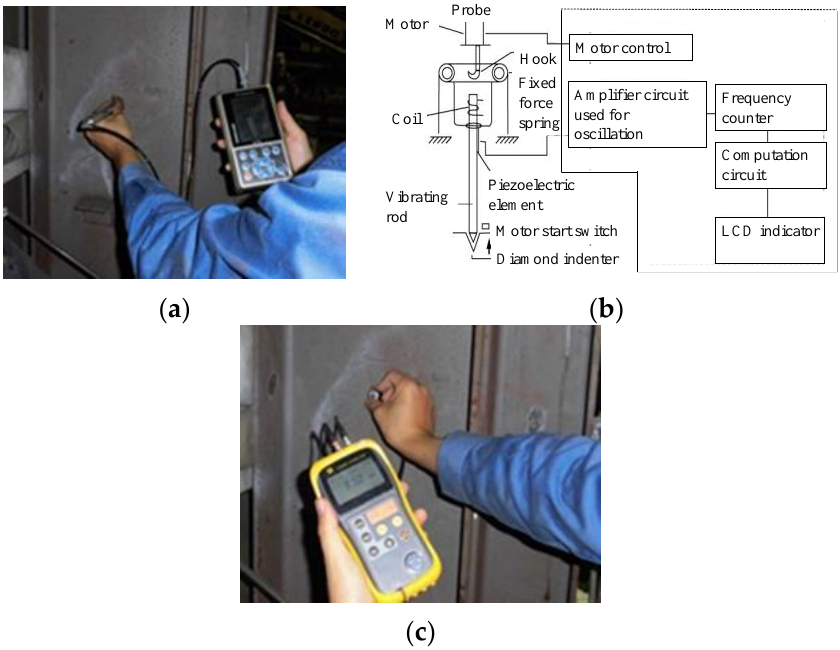
Figure 3. ( a ) A portable hardness tester and ( b ) the measurement principle of the portable hardness tester. ( c ) Portable thickness gauge.